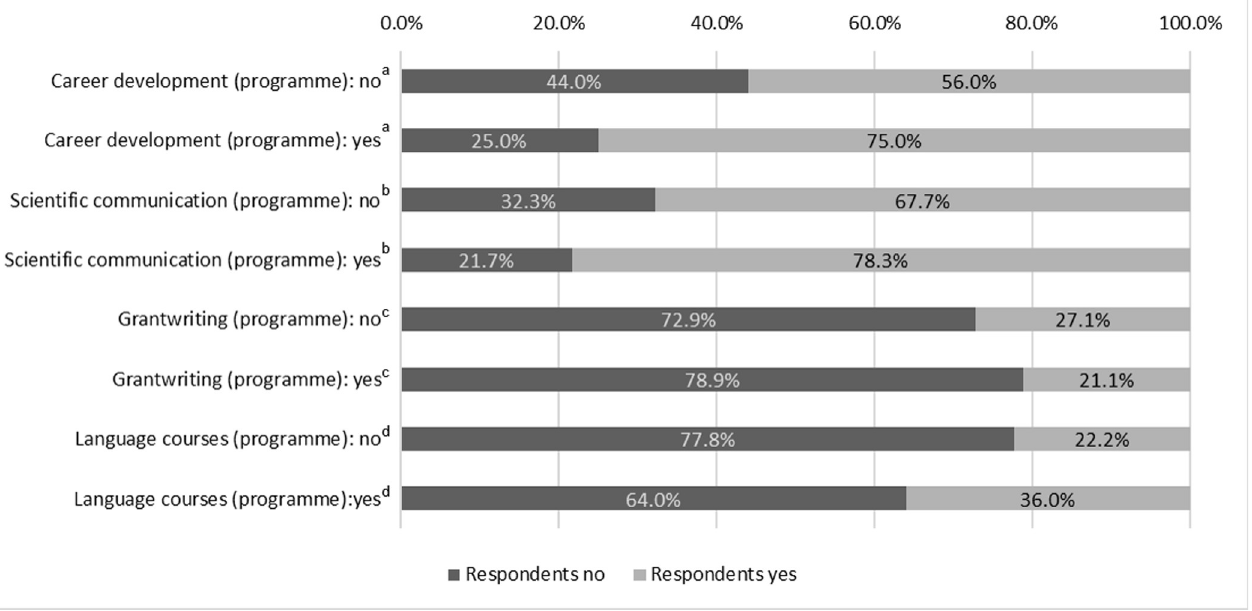
Fig 6. Regulations on doctoral training of structured doctoral programmes and practices reported by their graduates ( N = 229). a F = 0.147, p = 0.160; b F = 0.116, p = 0.271; c F = 0.057, p = 0.591; d F = 0.141, p = 0.185.